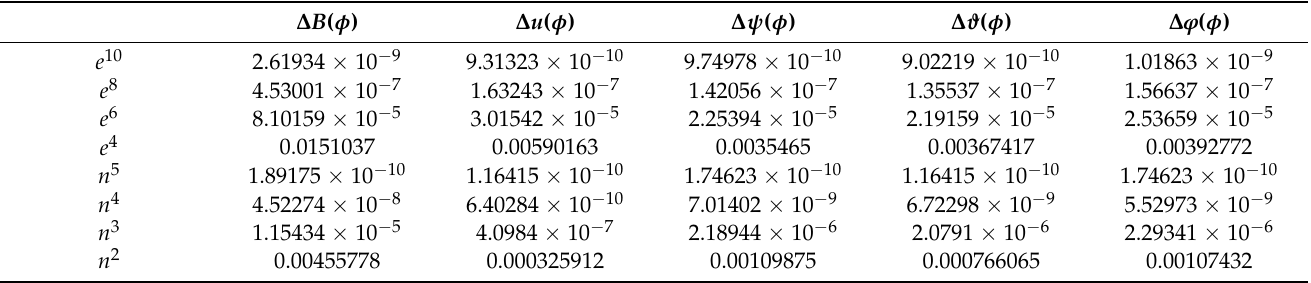
Table 12. Truncation errors of common latitude expanded to different orders with geocentric latitude as the variable (units: arc